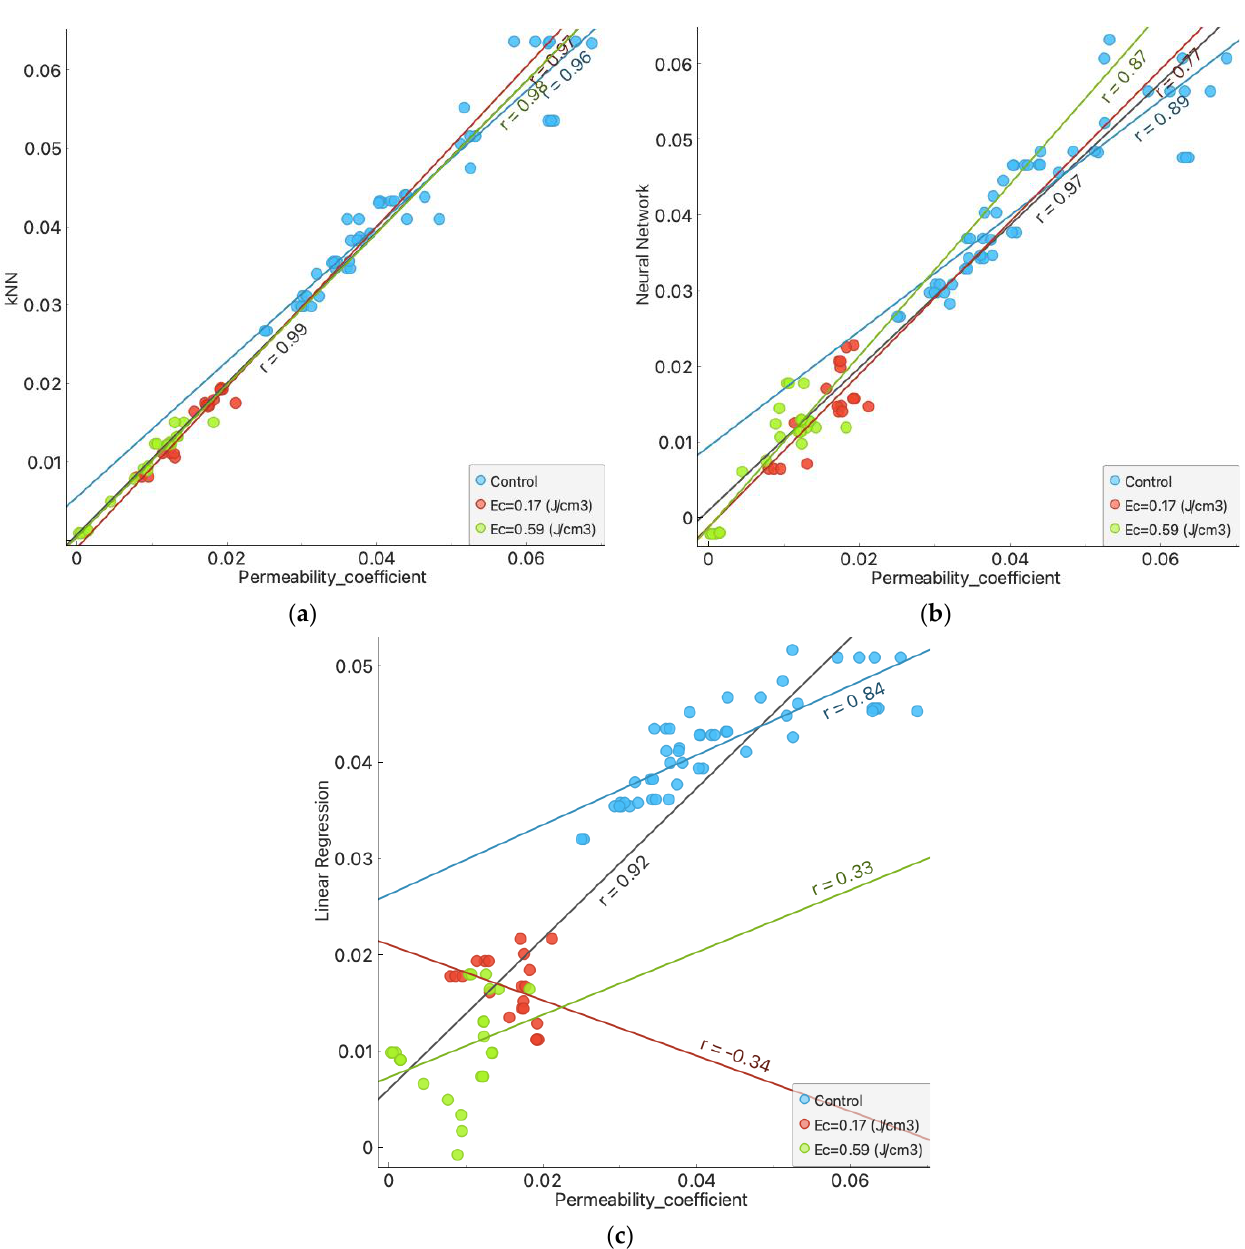
Figure 7. Regression plot of the prediction results of each algorithm to the test results: ( a ) k-NN algorithm. ( b ) Neural network algorithm. ( c ) Linear regression.